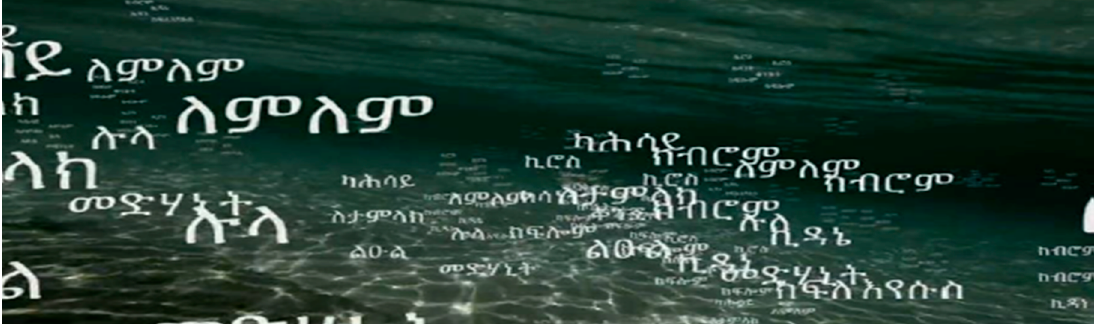
Figure 2. Names of people without bodies, meaningful names (i.e., Selam/Peace or Tesfaye/My Hope) of migrants who lost their lives crossing the Mediterranean (“Asmat” still frame, used by permission).